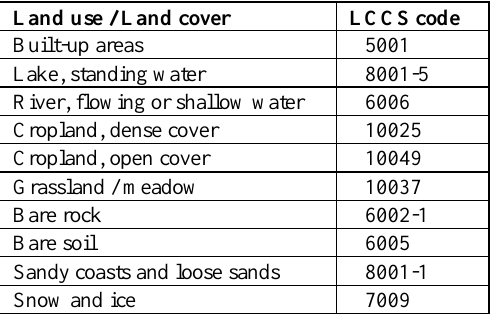
Table 2. Land use classification